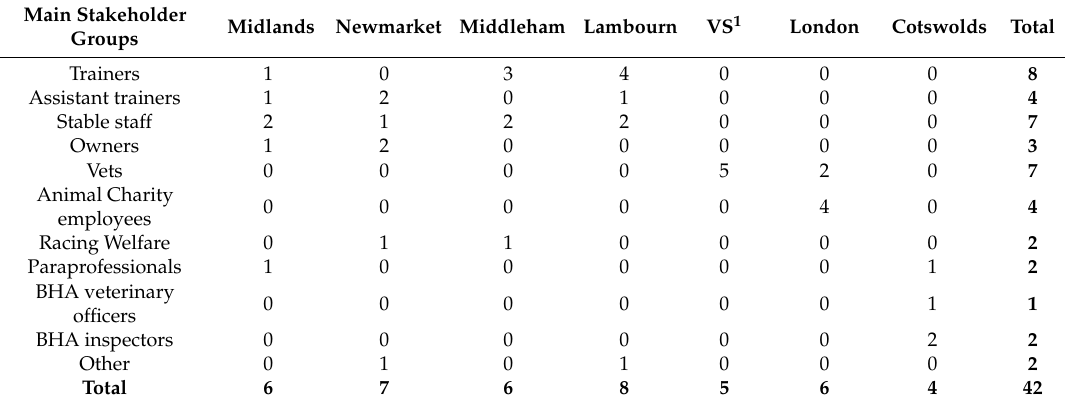
Table 1. Demographic breakdown of focus group participants by occupation and location. Main Stakeholder